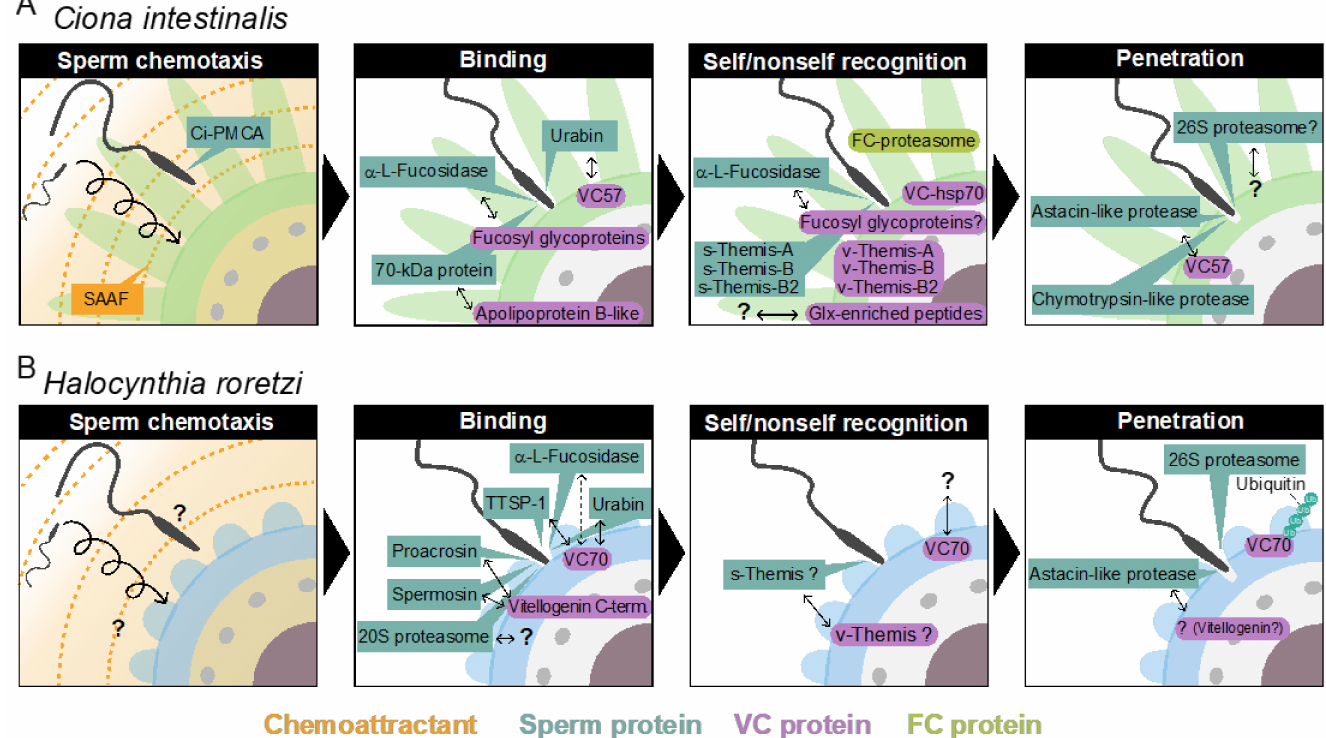
Figure 2. Fertilization processes of C . intestinalis and H . roretzi . ( A ) Fertilization processes in Ciona intestinalis . Sperm are activated and chemoattracted to the eggs. Then, the sperm binding to the VC is mediated by the sperm CiUrabin and α -L-fucosidase. The binding partners on the VC are CiVC57 and fucosyl-glycoproteins. Upon sperm binding, self/nonself recognition is carried out by sperm Ci-s-Themis-A, B, and B2 and the same haplotypic recognition partners on the VC and Ci-v-Themis-A, B, and B2. In the penetration process, sperm chymotrypsin-like protease, astacin-like protease, and the 26S proteasome appear to function as a lysin or lysin system. ( B ) Fertilization processes in Halocynthia roretzi . Sperm binding to VC is mediated by sperm HrUrabin,